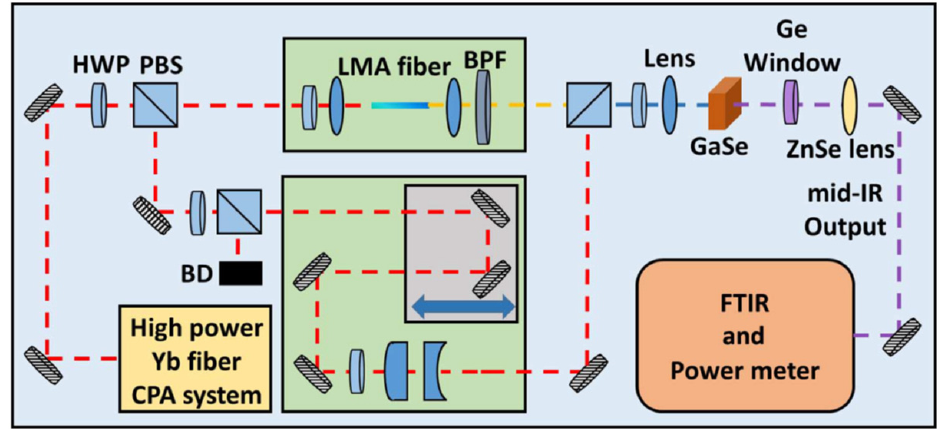
Figure 6. Schematic diagram of the ultrafast MIR sources with a tunable range of 7–18 µm. Reprinted with permission from [114] © The Optical Society. A home-built, 14.5 W, 165 fs, and 30 MHz Yb: fiber system is used as the front-end experimental setup for the MIR generation. The laser output is split into two paths by a half-wave plate (HWP) together with a polarization beam splitter (PBS). One path of light is coupled into a piece of large-mode-area (LMA) fiber for SPM-enabled spectra broadening, and then a bandpass filter is used for targeted wavelength selection to generate tunable femtosecond signal pulses. The other optical path serves as the pump for subsequent DFG in a GaSe crystal.